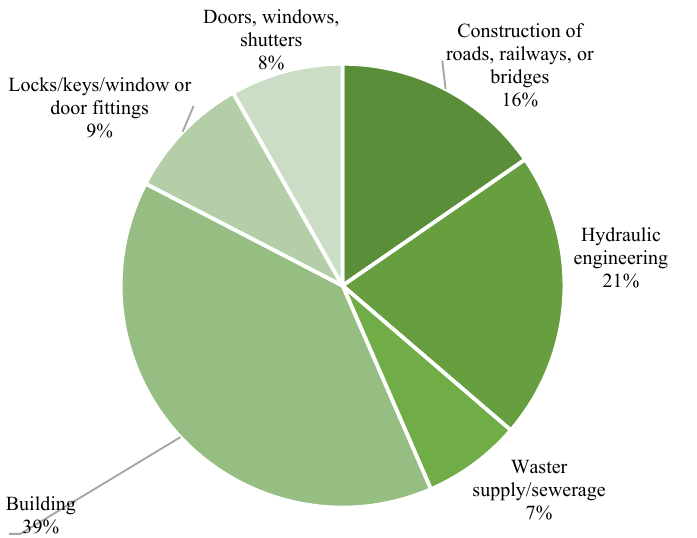
Figure 2. Composition of valid patents in the building construction industry in the YRD, China.